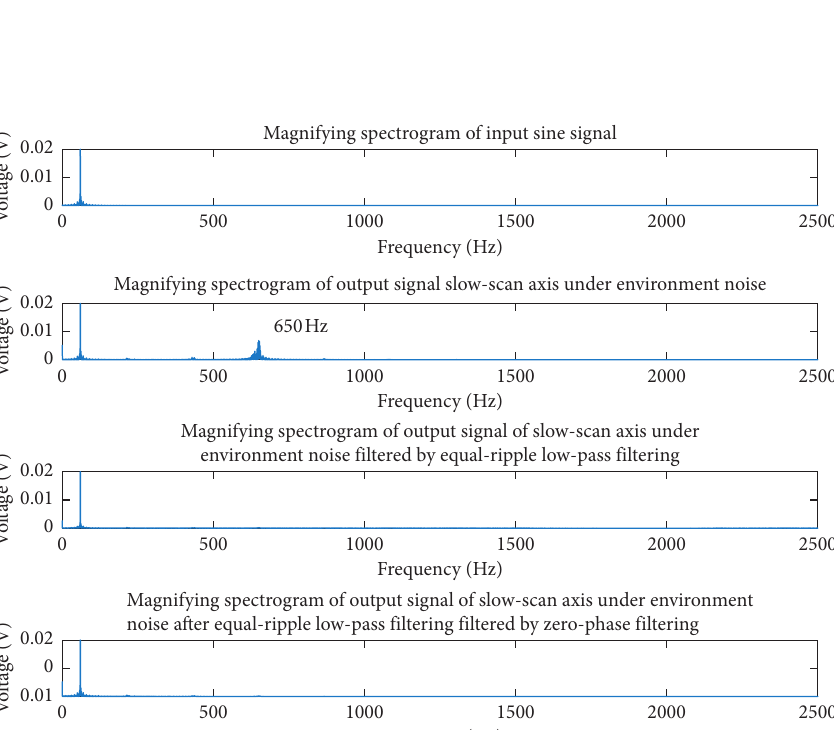
Figure 4: Validation of filters in aspect of